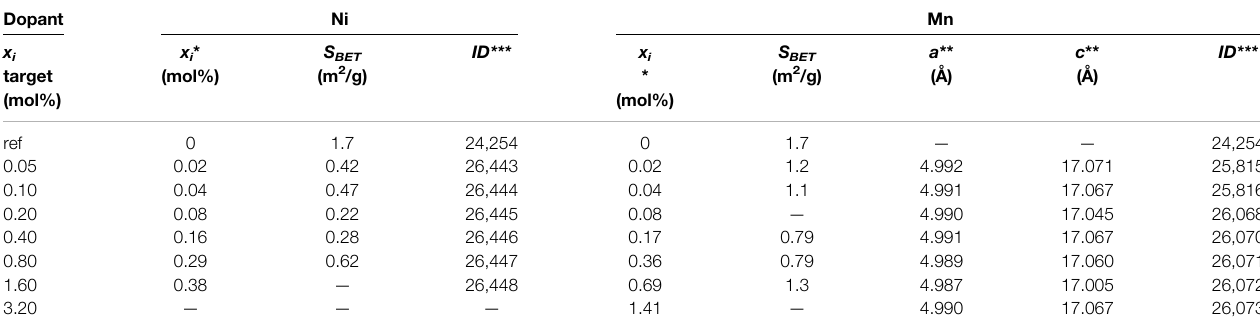
TABLE 2 | Synthesis data of precipitated carbonates. Dopant